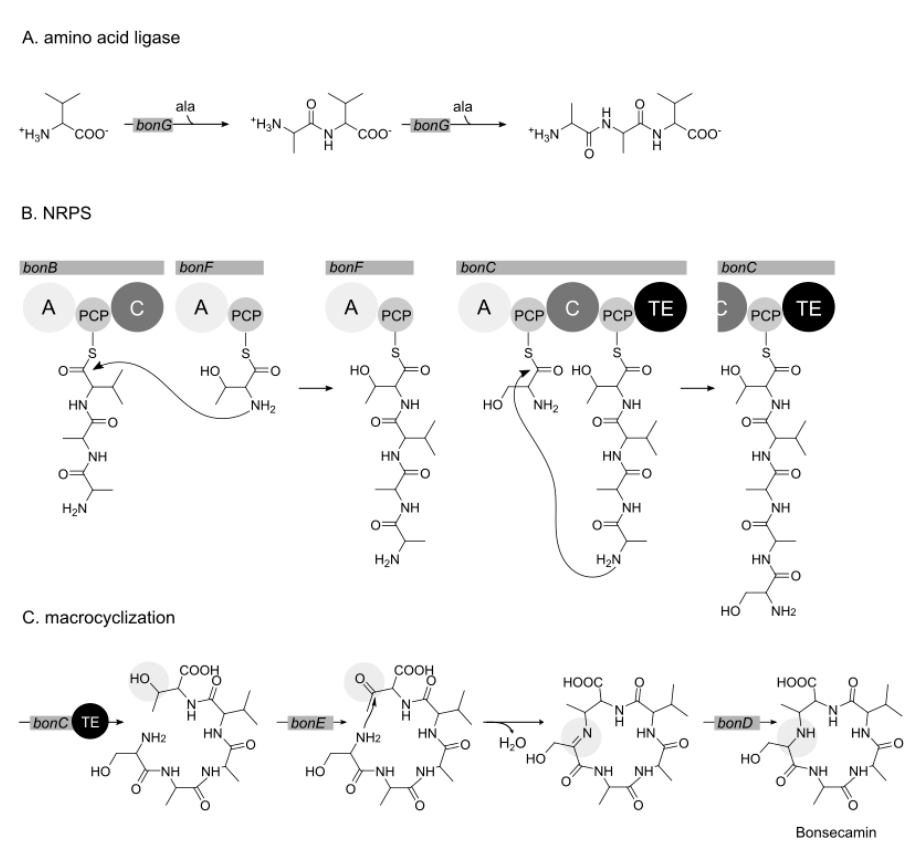
Figure 5. Proposed biosynthetic scheme for bonsecamin production. A. Formation of the Ala-Ala-Val tripeptide precursor catalyzed by the putative alanine ligase encoded by bonG . B. Conversion of the tripeptide intermediate into the linear pentapeptide precursor catalyzed by the NRPS encoded by bonB , bonF and bonC . C. Cyclization of the linear bonsecamin precursor catalyzed by the products of bonE and bonD .